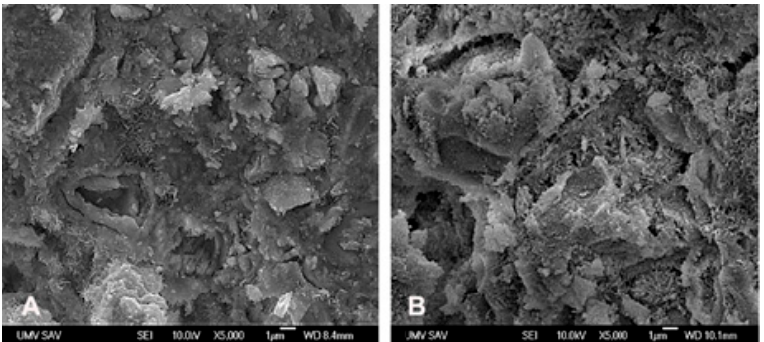
Figure 1. Microstructures of cements after hardening in simulated body fluid. ( A ) Irregularly shaped micropores with 1–5 µ m size, larger agglomerates of 1–3 µ m size composed of fine submicrometric globular particles and thin plate-like hydroxyapatite particles up to 500 nm length in C cement; ( B ) bigger micropores up to 10 µ m dimension as a result pulling out of coarser calcium phosphate agglomerates from microstructure in CAK